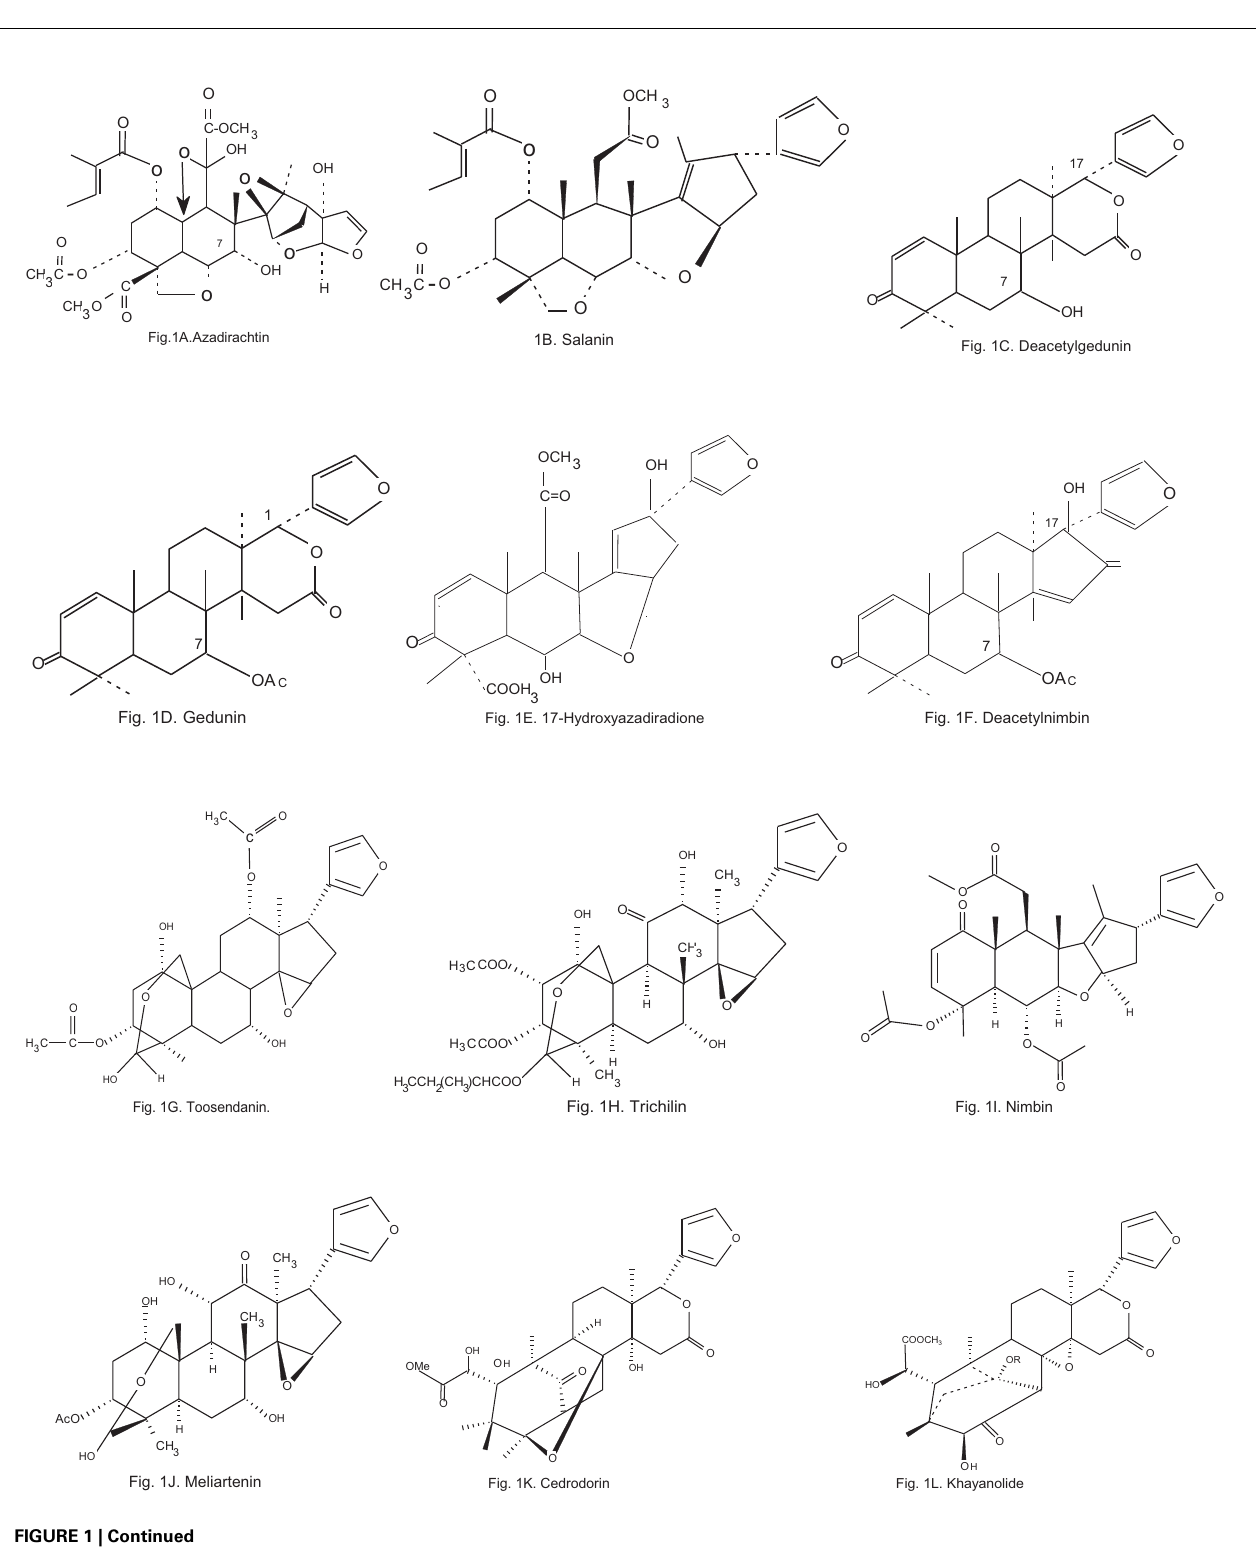
Fig. 1G. Toosendanin. Fig. 1H. Trichilin